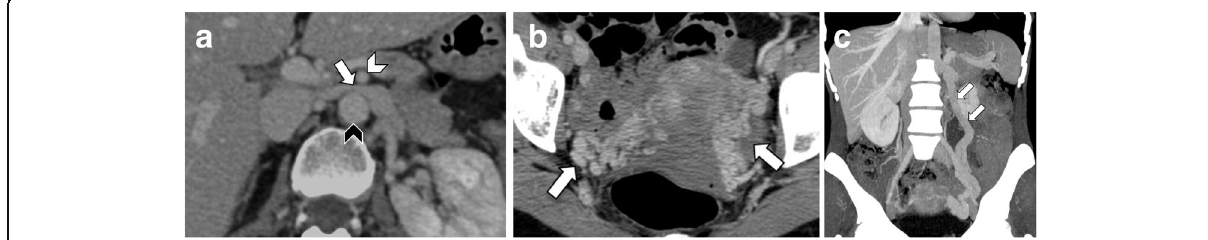
Fig. 7 A 50-year-old woman with anterior nutcracker syndrome. a Axial contrast-enhanced CT image on the portal venous phase shows the typical “ beak sign ” (arrow) with left renal vein compression between the aorta (black arrowhead) and superior mesenteric artery (white arrowhead). b CT image at the level of the pelvis demonstrates multiple pelvic varices (arrows). c Coronal reformatted CT MIP image shows marked dilatation of the left ovarian vein